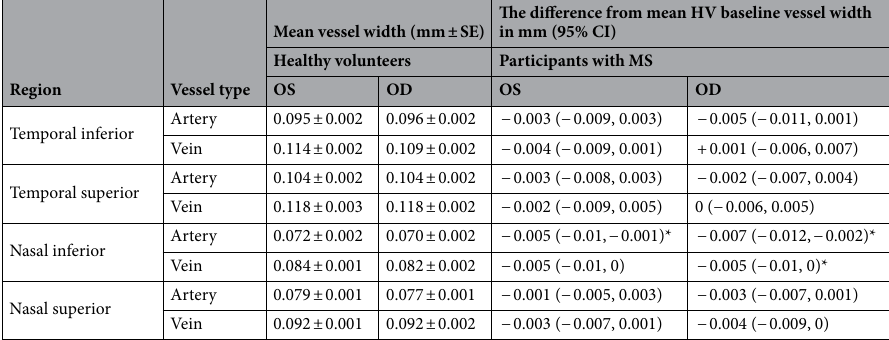
Table 4. Baseline UWF-SLO data. The difference in mean arterial and venous width for MS participants when compared to the baseline vessel width of healthy volunteers using an unpaired samples Student’s t-test, in four quadrants. SE, Standard error; CI, Confidence interval; OS, Left eye; OD, Right eye. * p < 0.05; ** p < 0.01; *** p < 0.001.